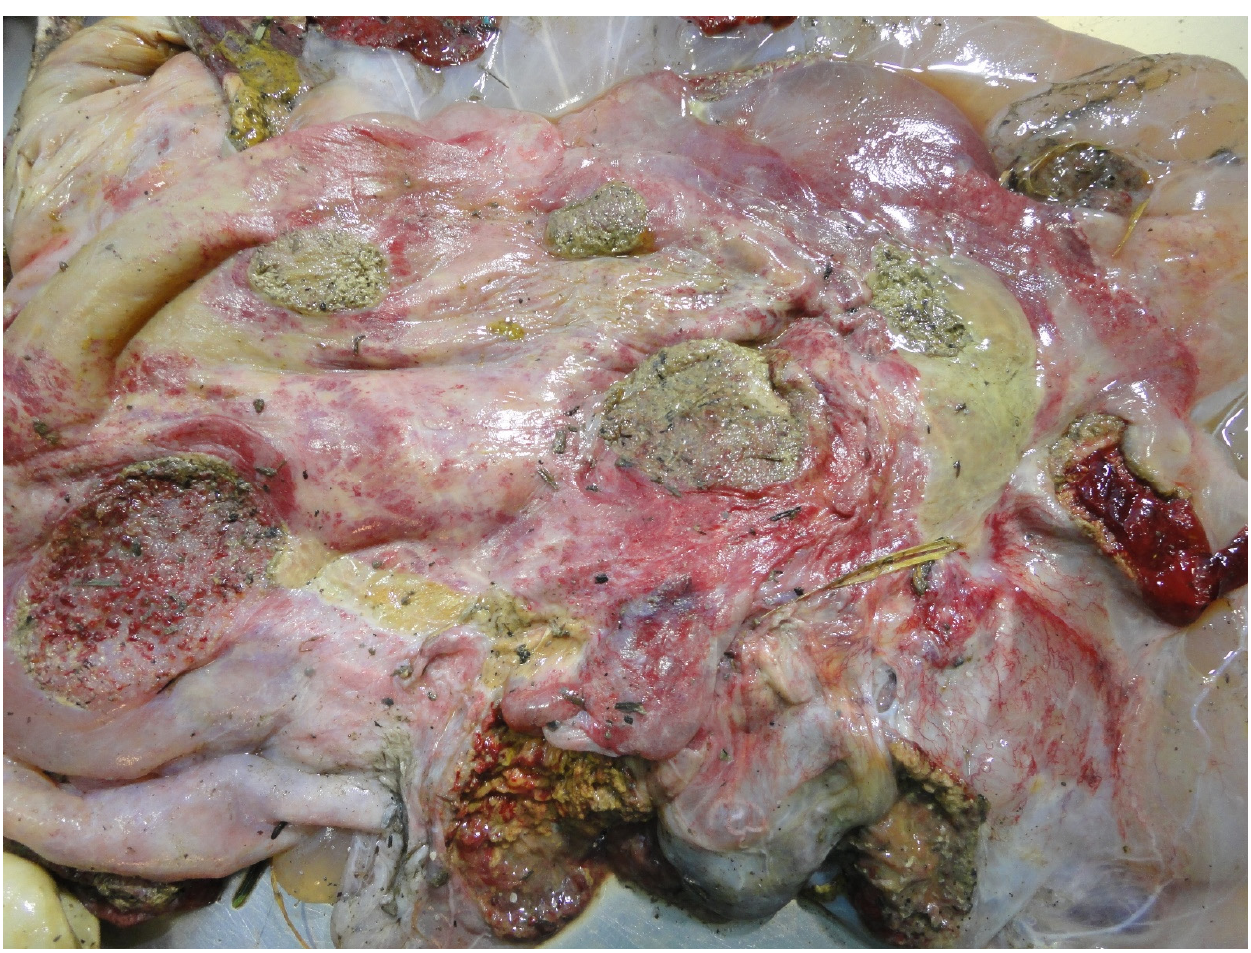
Figure 9. Severe cotyledonary and intercotyledonary placentitis.